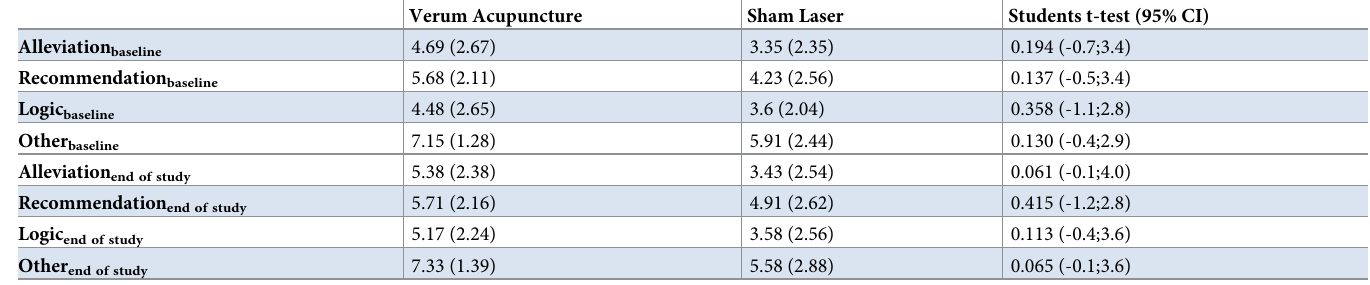
Table 2. Credibility assessment. The assessment was perfomed at baseline and at the end of the study indicating no significant differences in regard to expectations between the Sham and the Verum Group. 95% CI = confidence